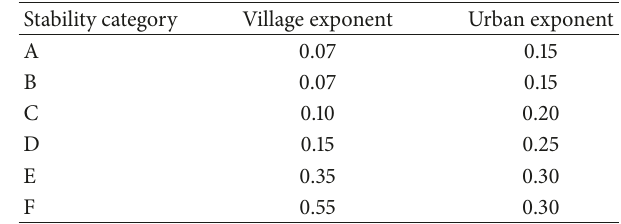
Table 2: The power 𝑝 value for wind-speed profile